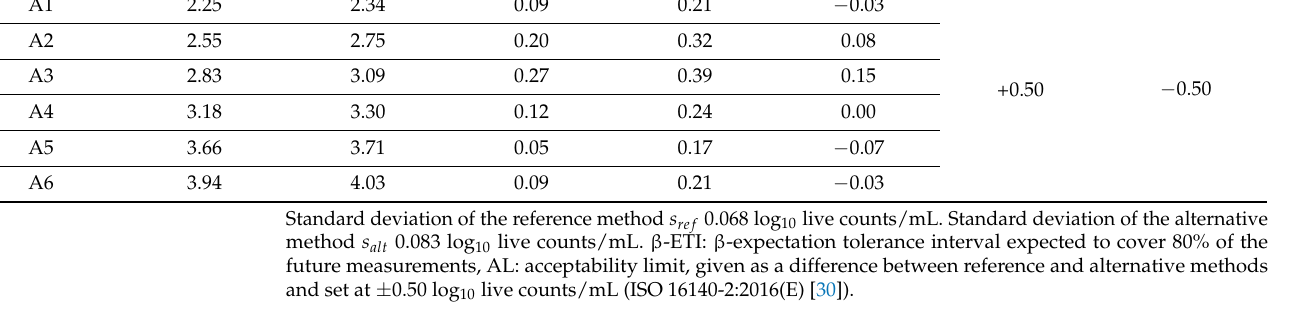
Table 6. Results of the accuracy profile study on chicken neck skin for C. jejuni [log 10 live counts/mL].